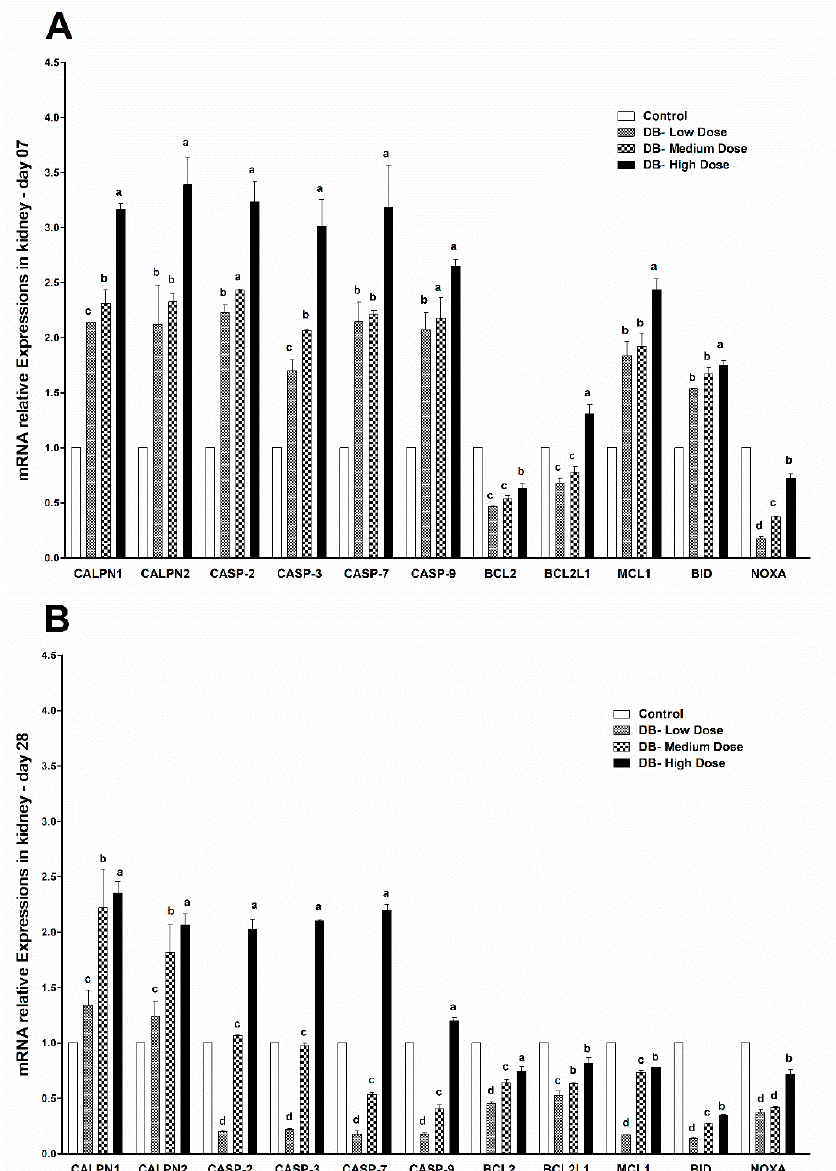
Figure 7. Effects of DB supplementation on kidney mRNA expressions of apoptosis-related genes at 07 days ( A ) and 28 days ( B ) of age. Data are presented as mean value ± SEM (n = 6). Values without the same mark (a–d) represent statistically significant differences ( p < 0.05). CALPN1, Calpain 1;